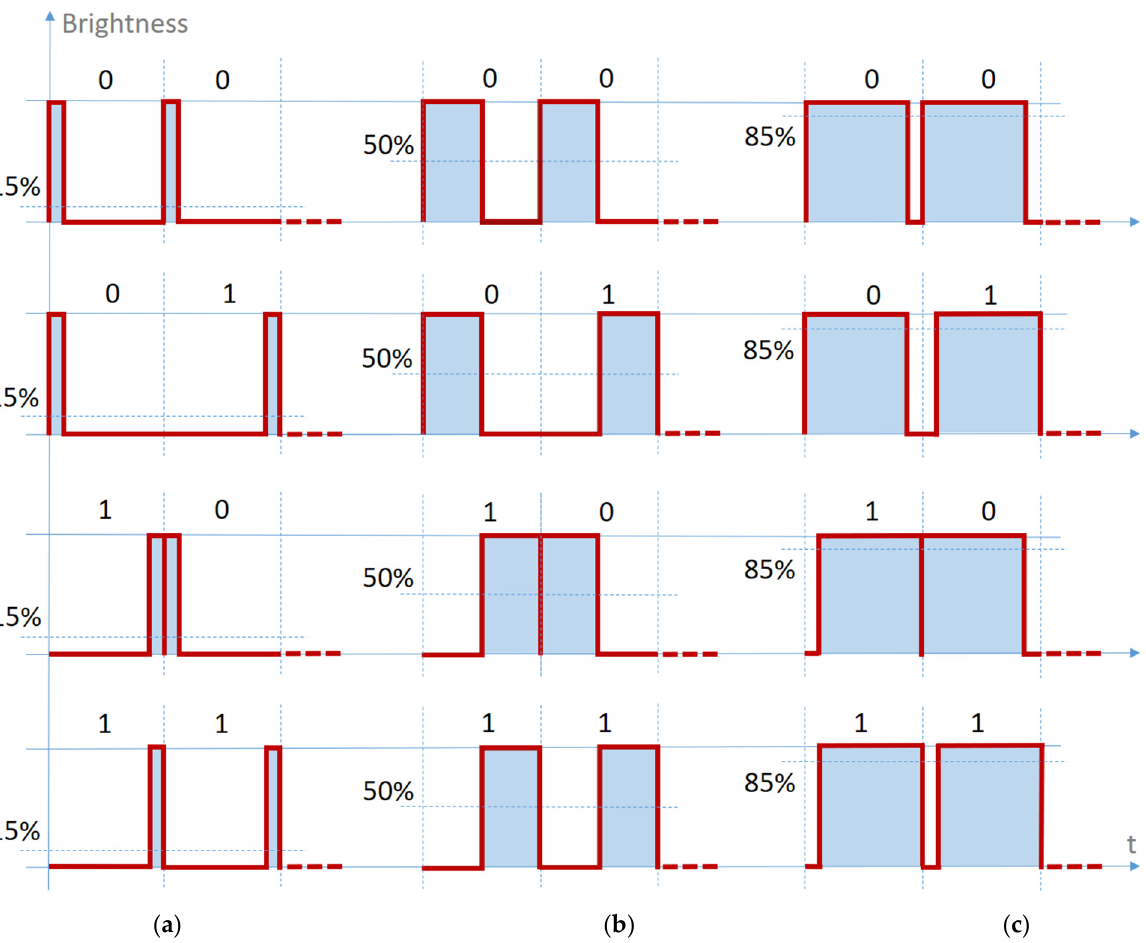
Figure 6. The VPPM standard scheme: ( a ) Average brightness less than 50%; ( b ) Average brightness equal to 50%, the same as Manchester coding; ( c ) Average brightness greater than 50%.